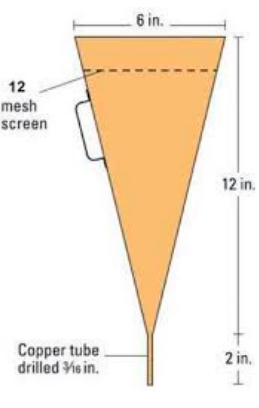
Figure 2. March funnel.